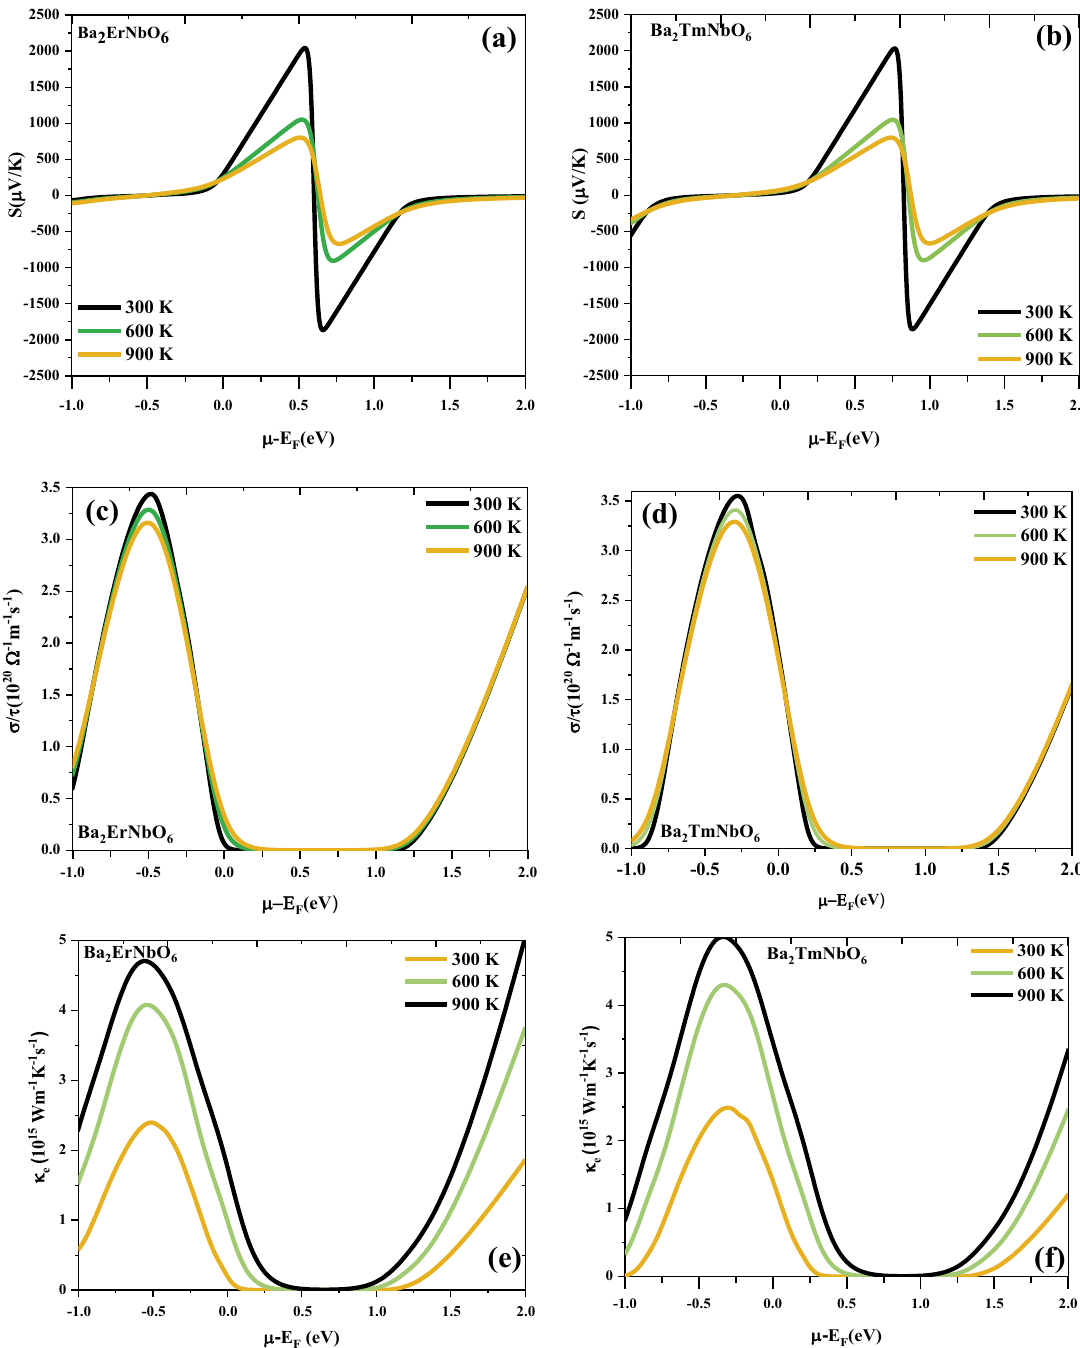
Figure 8. ( a – h ) Variation of ( a , b ) Seebeck coefficient (S), ( c , d ) electrical conductivity (σ/τ), ( e , f ) electronic thermal conductivity (κ e ), ( g , h ) Figure of merit (zT) versus chemical potential of Ba 2 ErNbO 6 and Ba 2 TmNbO 6 . Different colors are used to distinguish the temperature: Black-300 K; Green-600 K; and Wine-900